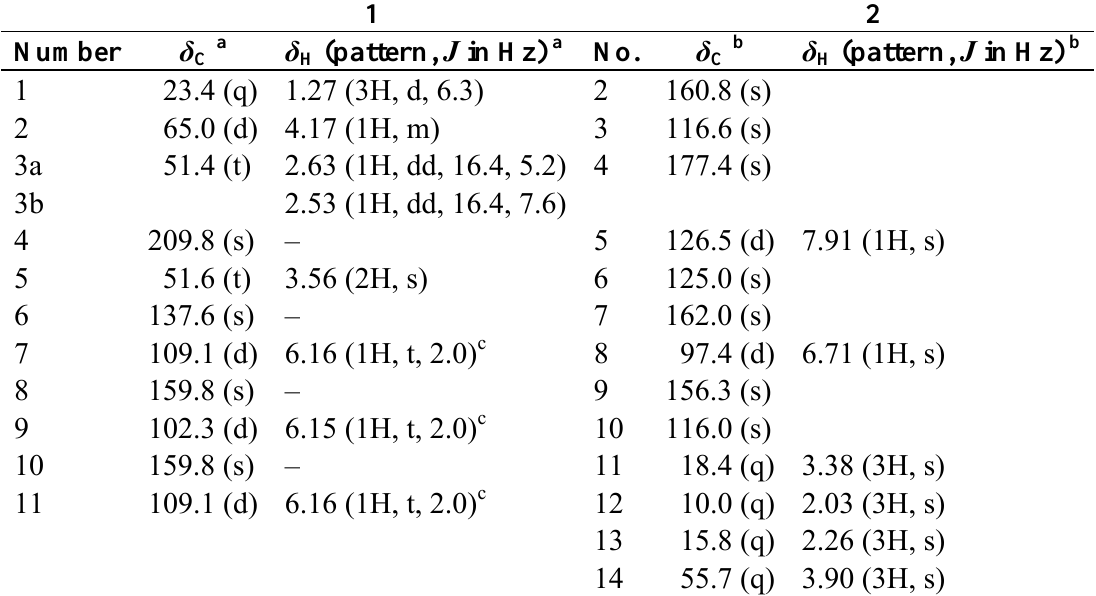
Table 1. 1 H (500 MHz) and 13 C (125 MHz) data of compounds 1 and 2